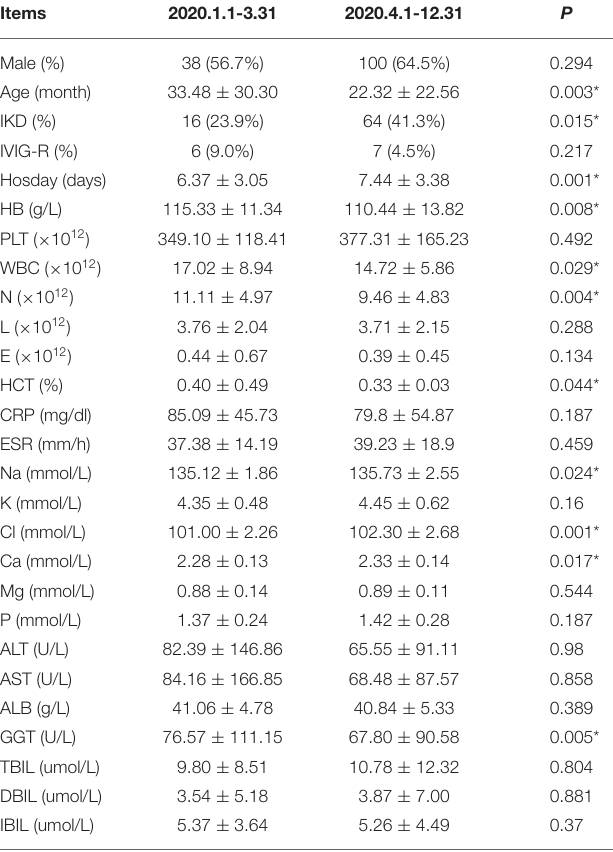
TABLE 3 | Demographic and clinical characteristics.